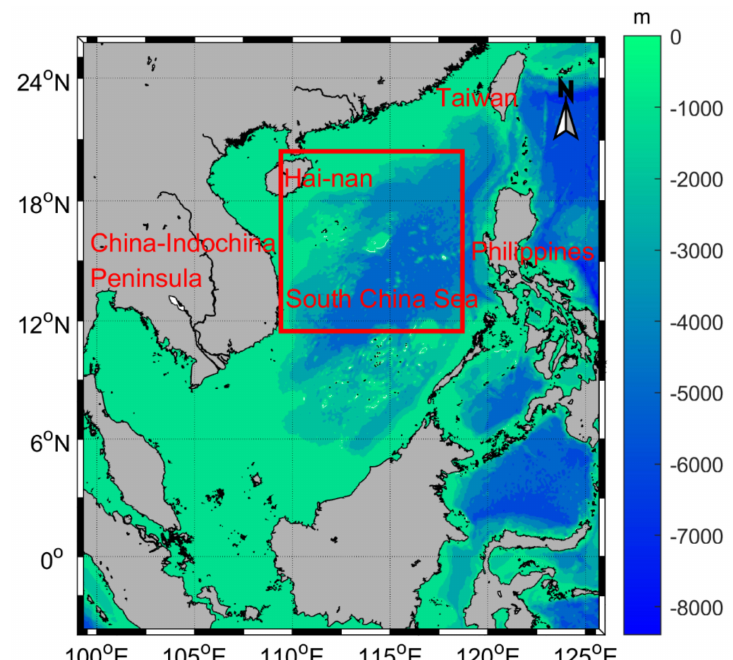
Figure 1. A bathymetric map of the South China Sea: The red box in the picture is the high frequency area where the temperature